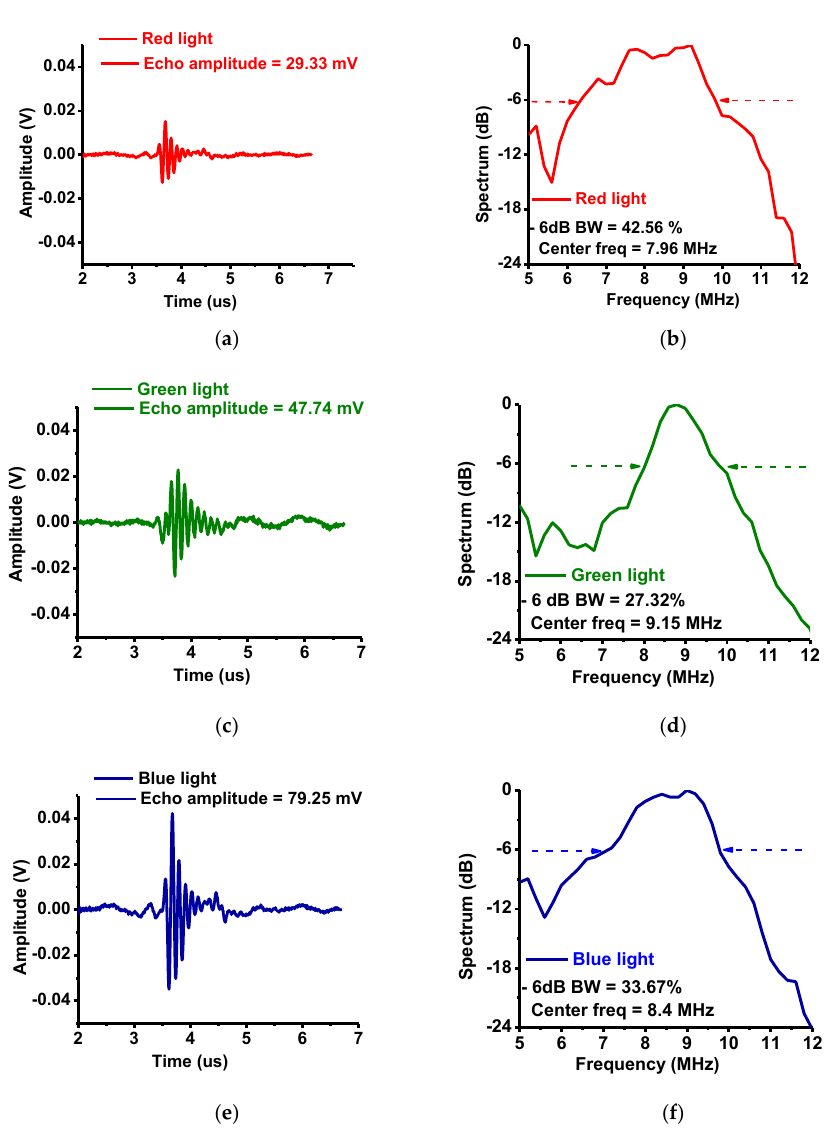
Figure 11. The echo waveform data of the developed system. ( a ) Echo amplitude and ( b ) its spectrum with red light, ( c ) echo amplitude and ( d ) its spectrum with green light, ( e ) echo amplitude and ( f ) its spectrum with blue light.